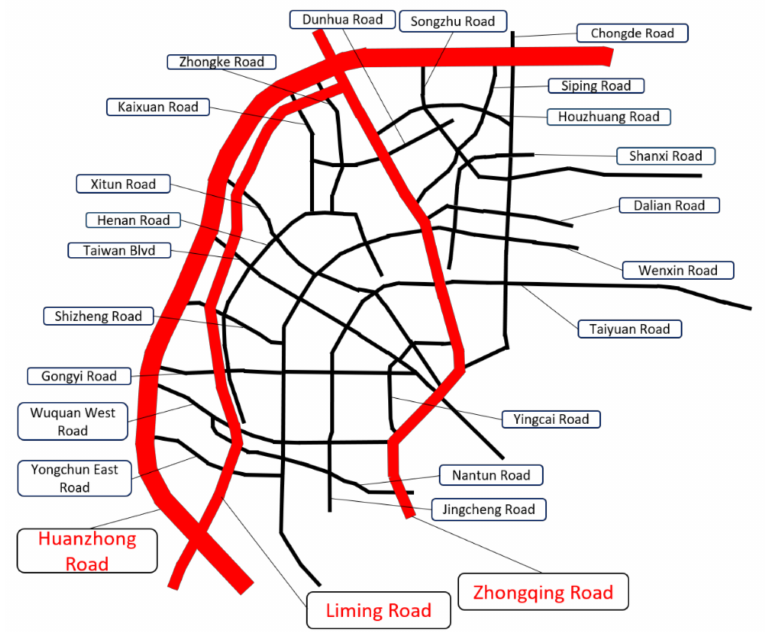
Figure 2. Road network of the selected urban area.